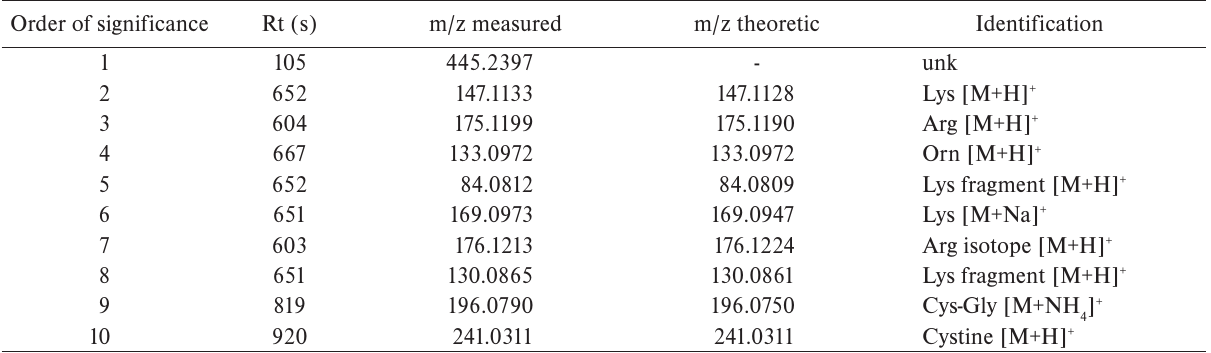
Table 3. List of ten most significant features differentiating patients with cystinuria from normal urine samples which were identified using partial least squares regression.